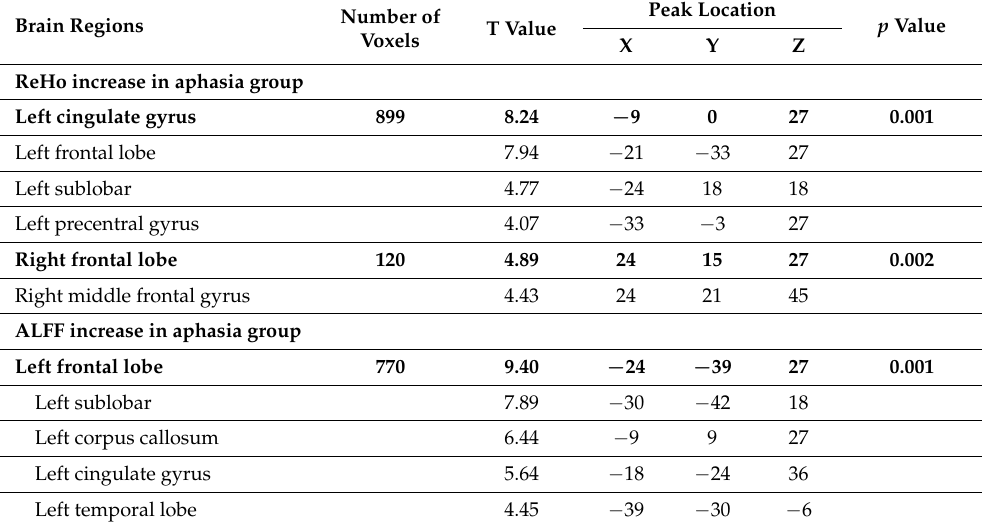
Table 3. The ReHo and ALFF values were increased in the patients with aphasia compared to those in the healthy